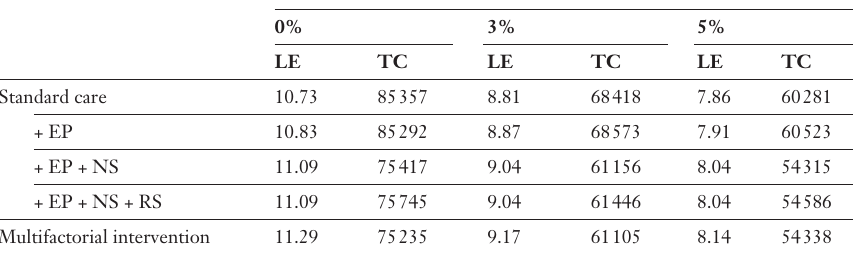
3%-discounted mean total lifetime costs (TC) (CHF in 1996 val- ues) per type 2 dia- betes patient with and without interven- tions, broken down by cost element.